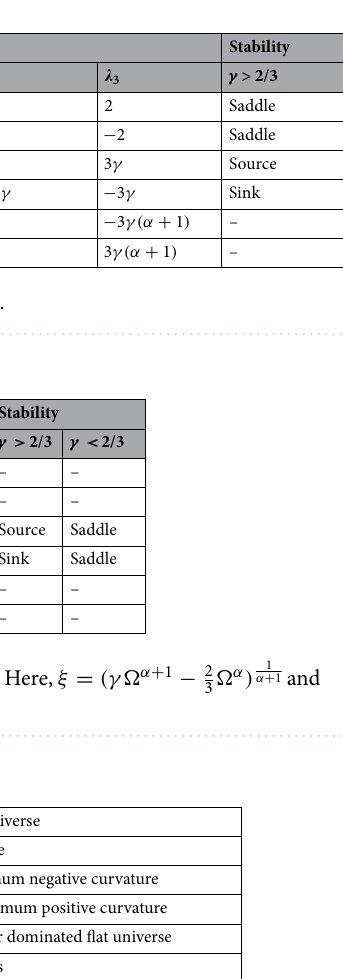
Table 3. Cosmological implications of the equilibriums.